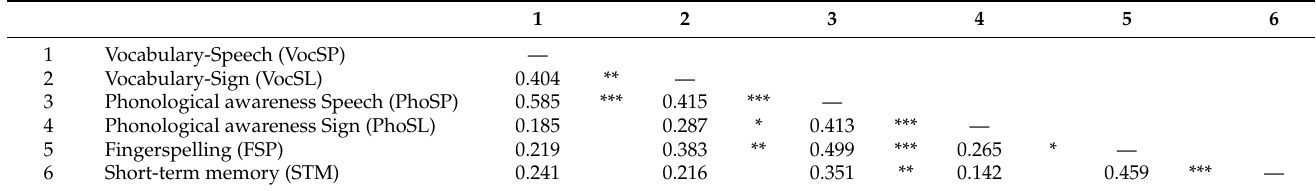
Table 2. Overview of correlations between predictor variables for deaf children at time 1 with age partialled